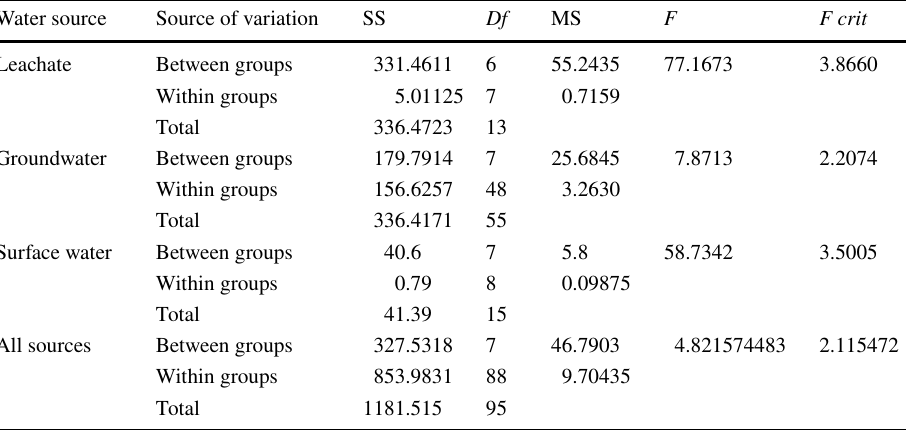
Table 7 Summary of AHCA results of the tested natural water